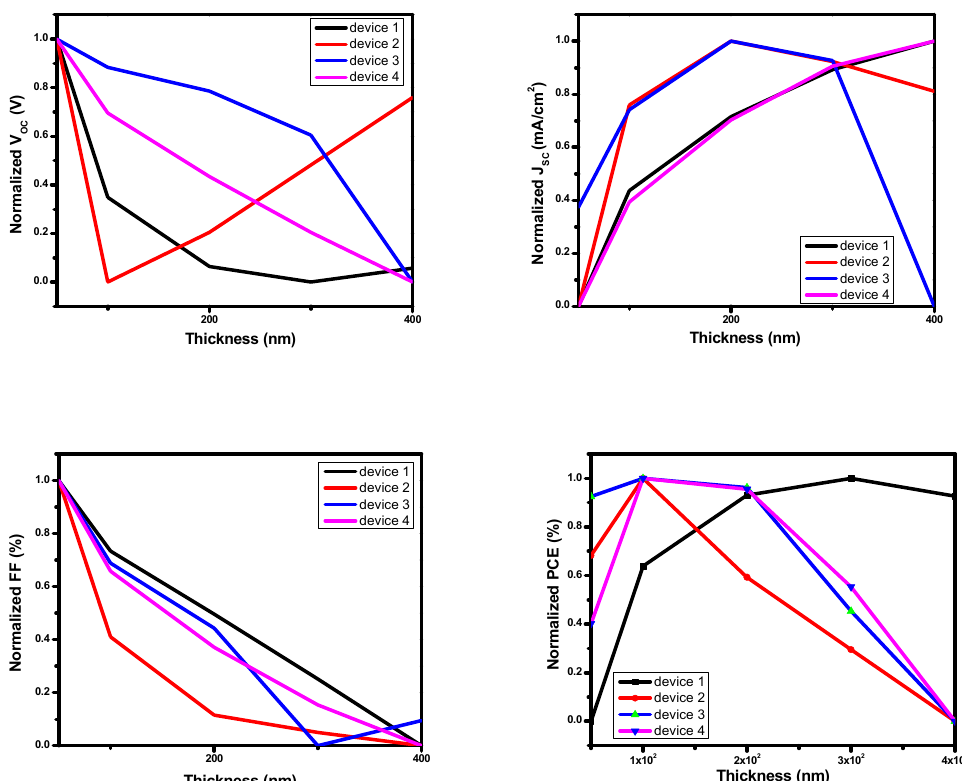
Figure 11. Values of V oc , J sc , FF and PCE for varying thickness of HTL with fixed thickness of ETL and K 2 TiI 6 .